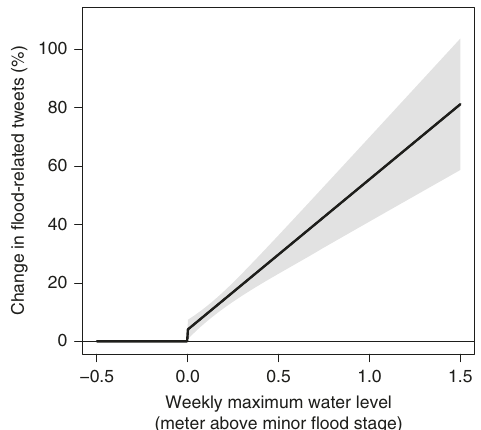
Fig. 2 Estimated relationship between weekly maximum tide height and the % change in fl ood-related tweets, using the functional form given in Eq. (1). This is estimated using data from all counties, aggregated to the weekly level. Fixed effects by county, state-month, and year are included, as well as controls for cumulative weekly rainfall (quadratic) and the number of users (see “ Methods ” section). Shaded areas show the 95% con fi dence intervals, with standard errors clustered at the state